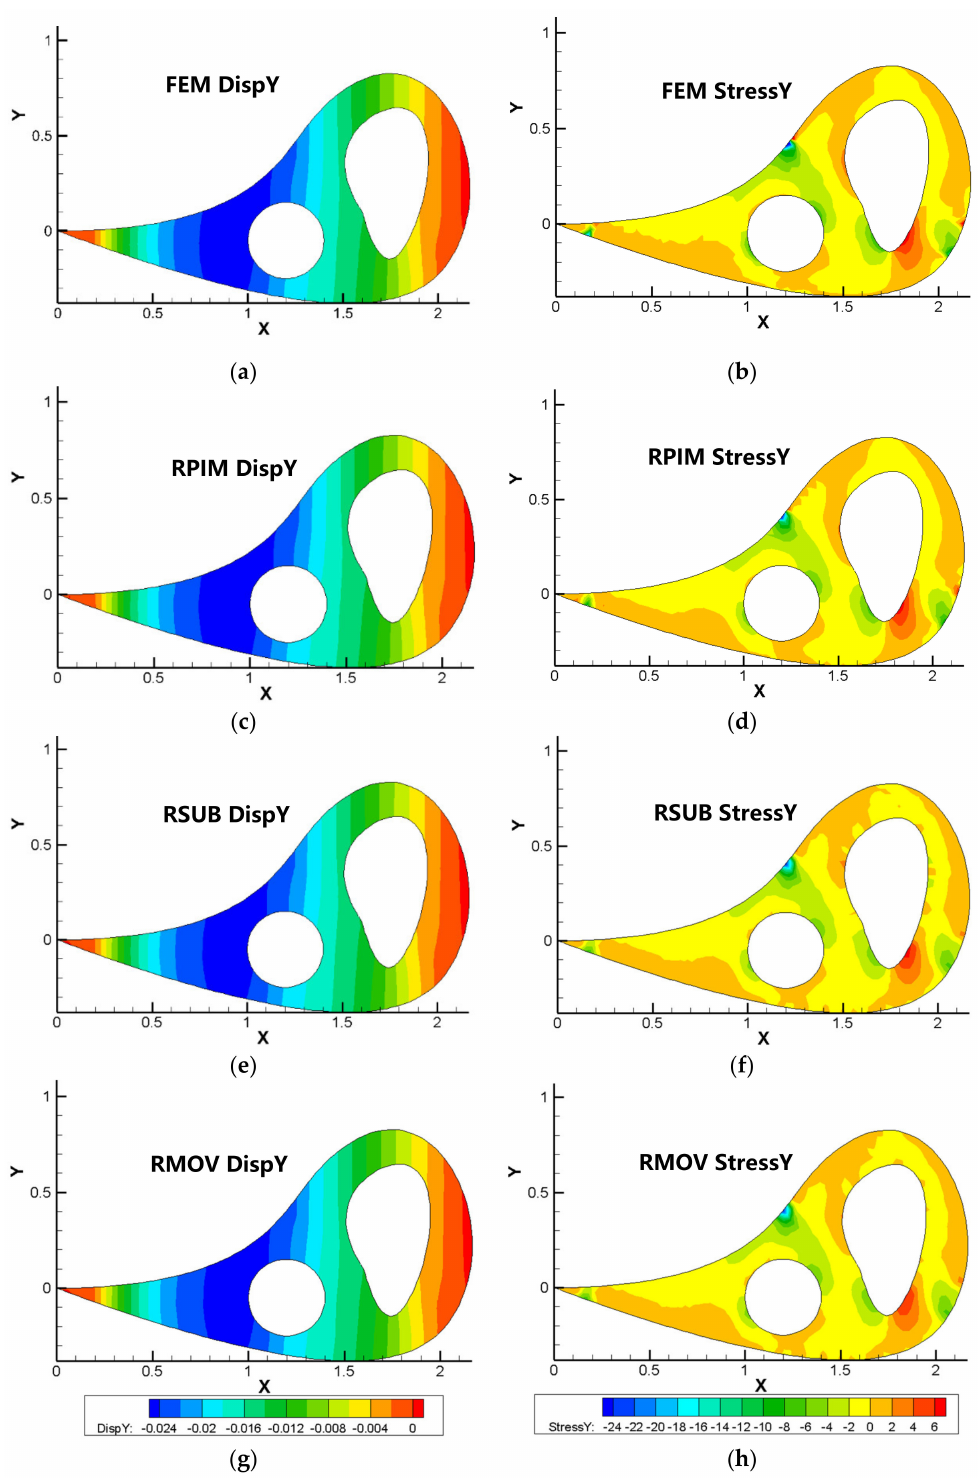
Figure 20. Displacement in y-direction of di ff erent methods: ( a ) FEM; ( c ) RPIM; ( e ) RSUB; ( g ) RMOV. Stress in y-direction of di ff erent methods: ( b ) FEM; ( d ) RPIM; ( f ) RSUB; ( h )